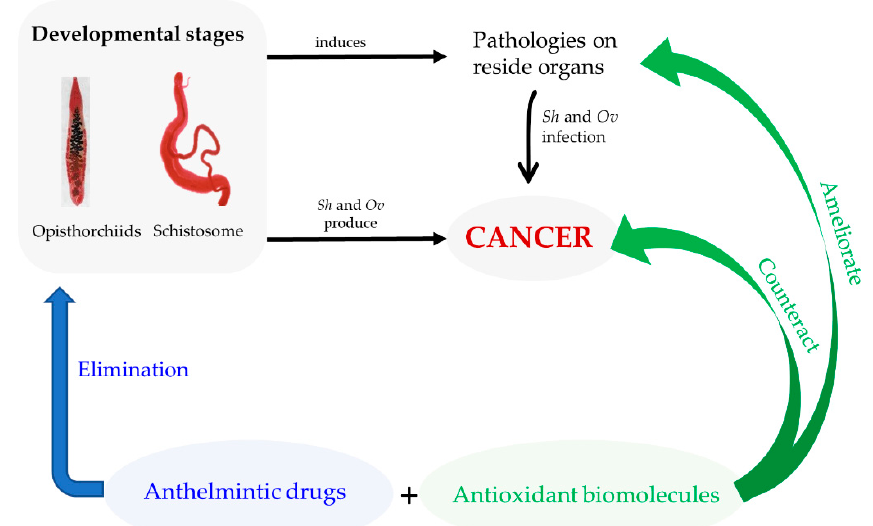
Figure 3. Novel therapeutic approach against schistosomiasis and opisthorchiasis and associated cancers. Through the combination of properties of anthelmintic drugs and biological properties of antioxidants biomolecules, new therapeutic approaches might be developed for anthelmintic therapy and to ameliorate infection induced morbidity. Ultimately, the presence of antioxidants could lead to counteract carcinogenesis through inhibition of the formation of reactive metabolites produced by the parasites.